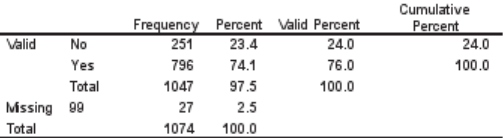
The preferred networks are Facebook, Twitter, Youtube, Instagram, Tumblr and Google+ with